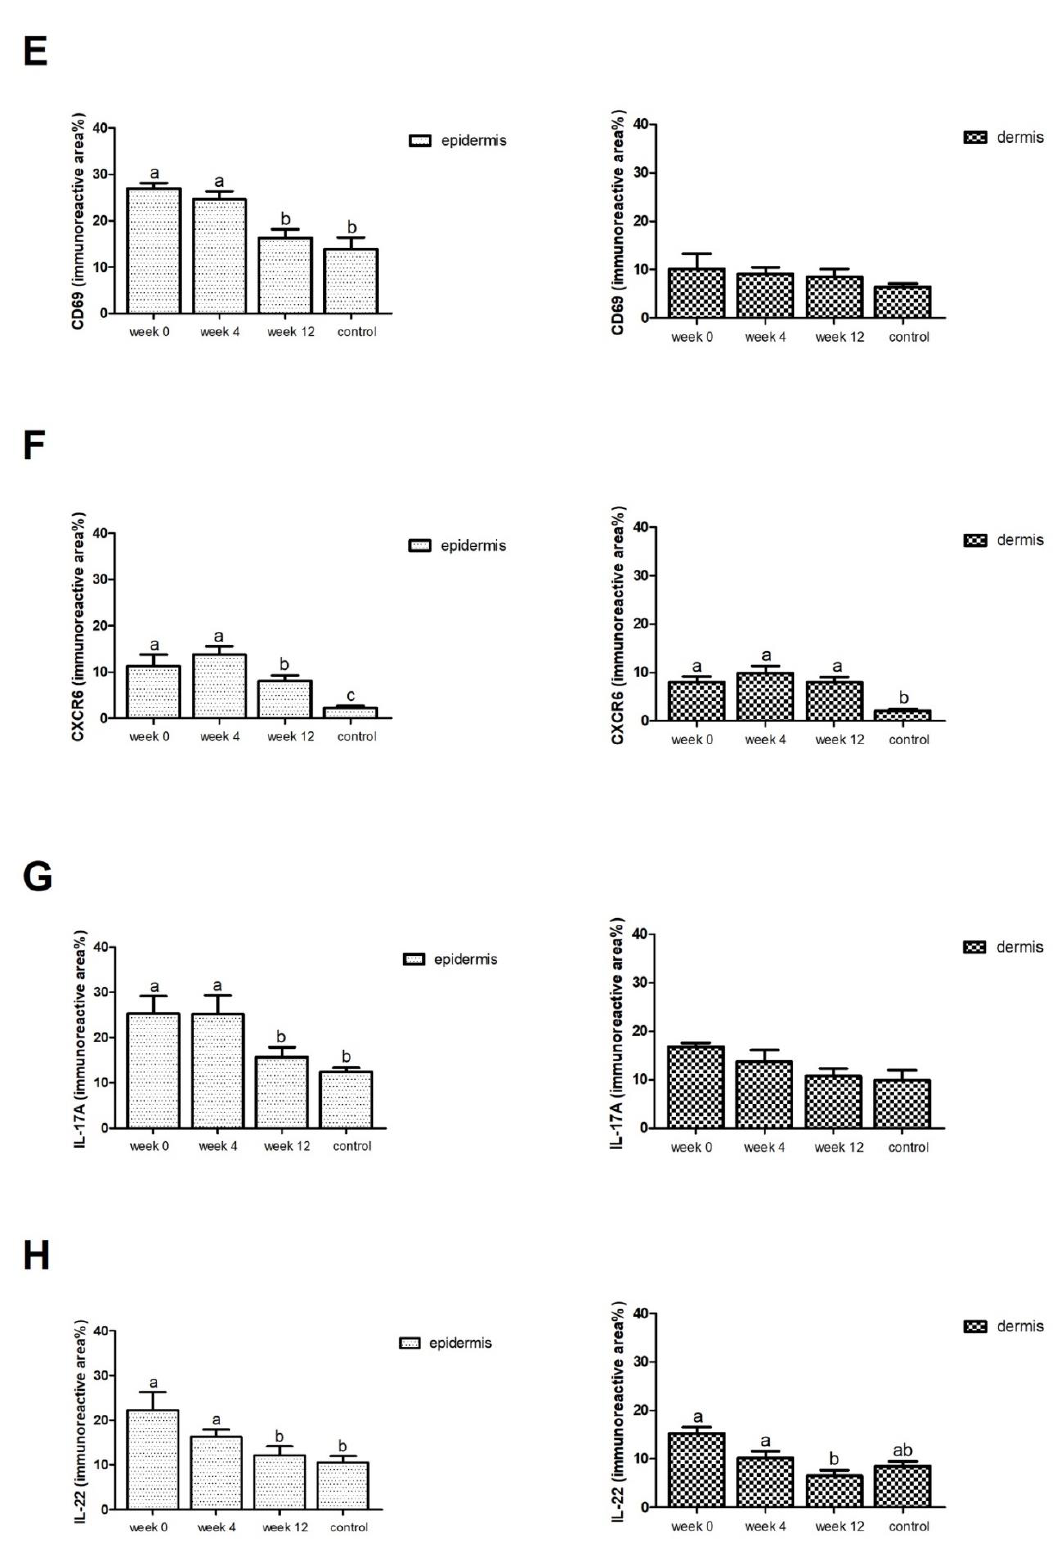
Figure 1. Immunoreactive area (means ± SEM) of TRM (in epidermis and dermis separately) of ( A ) CD8, ( B ) CD4, ( C ) CD103, ( D ) CD49, ( E ) CD69, ( F ) CXCR6, ( G ) IL-17A, ( H ) IL-22 in lesional skin during week 0, 4 and 12 ( n = 10) in comparison with healthy control ( n = 10, dermis and epidermis). Different letters indicate significant differences ( p < 0.05) between the various measurement points, whereas the same letters indicate a lack of differences ( p < 0.05).